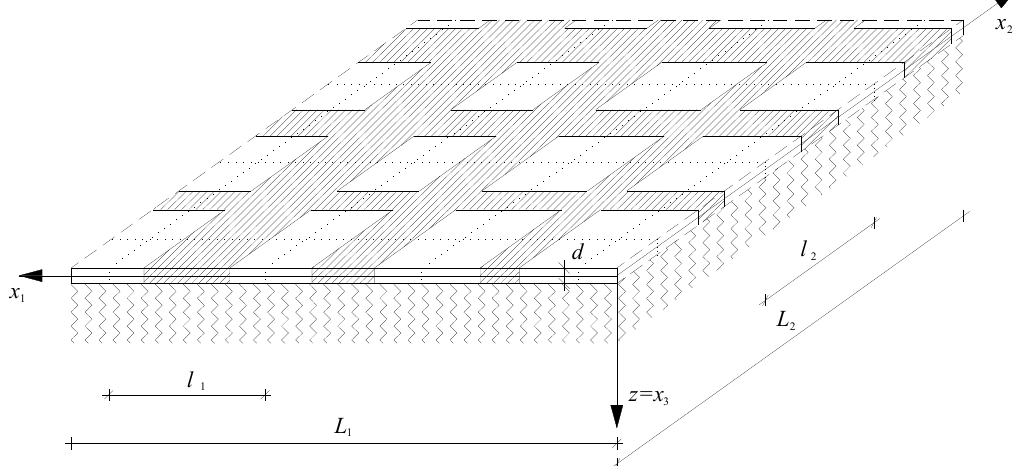
Figure 1. A fragment of a microstructured functionally graded plate (tolerance-periodic plate) on a heterogeneous elastic foundation.